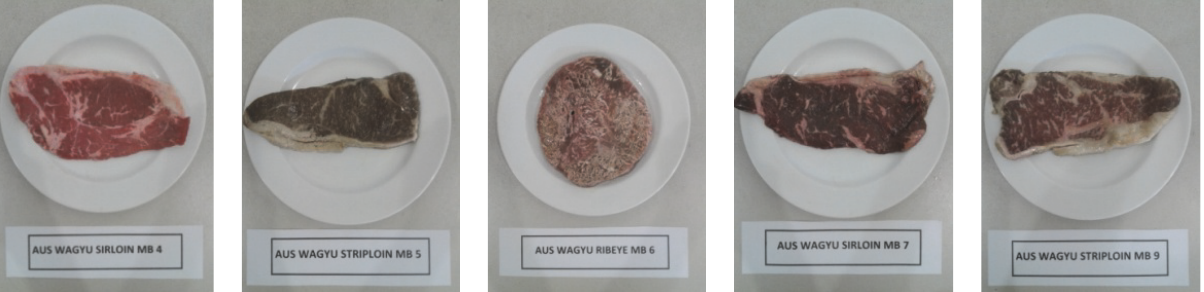
Figure 3: Samples of acquired beef images.